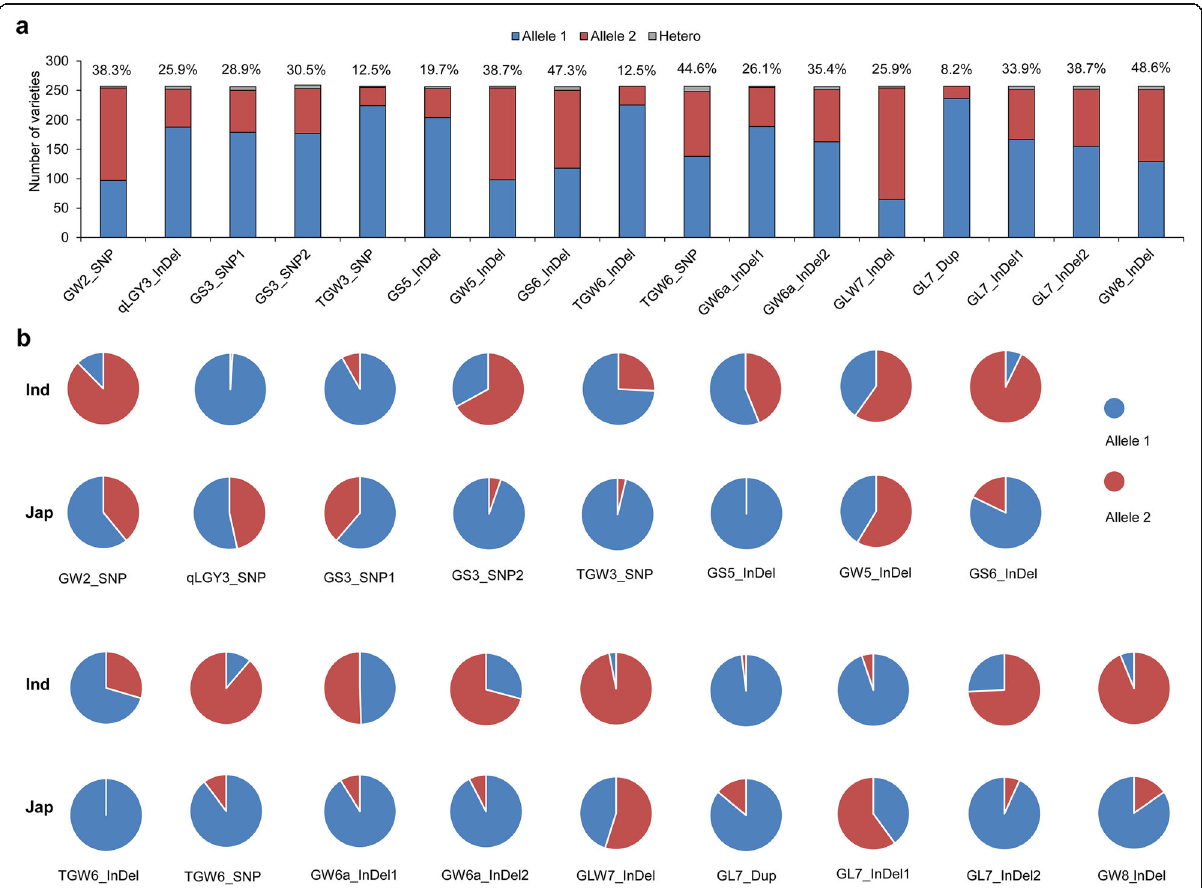
Fig. 4 Allele distribution of 17 FNPs in the RDP1 diversity panel. a Number of accessions with allele 1 or allele 2 of each FNP in the population. The minor allele frequency is labeled as percent on the top of columns. Allele 1 and Allele 2 represent the sequence variations of NIP- and non- NIP-type accessions respectively, and Hetero represents the heterozygote. b Allele ratio of different FNPs in two subspecies by pie chart. Ind and Jap represent indica and japonica subspecies respectively. Two colors denote the percent of two alleles for each